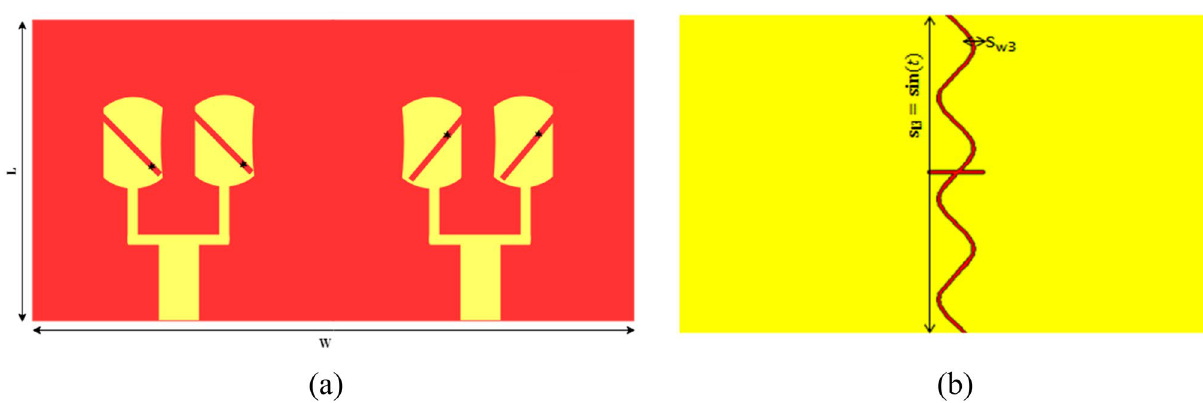
Figure 9. ( a ) Front view of MIMO. ( b ) Back view of MIMO with sin (t)